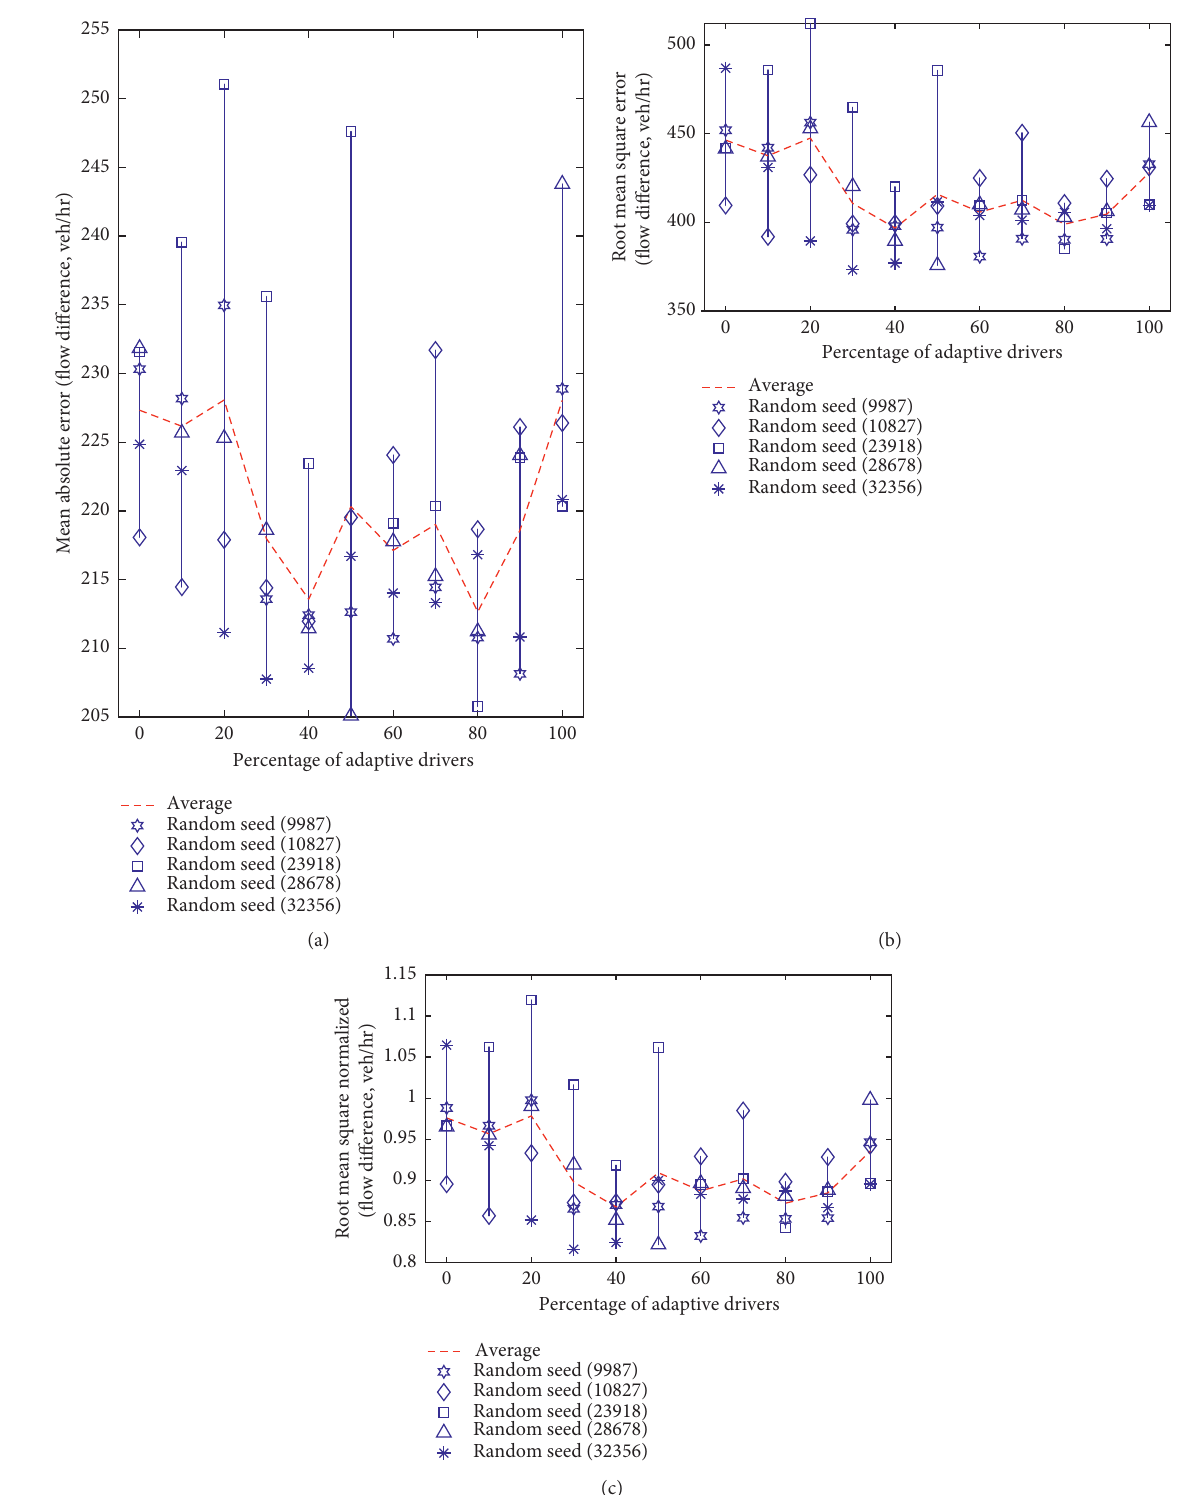
Figure 5: (a) MAE, (b) RMSE, and (c) RMSN for individual link flows from the SRC model with different adaptive driving compared to the DUE. X -axis shows percentage of adaptive drivers in the network for SRC and y -axis is the error in